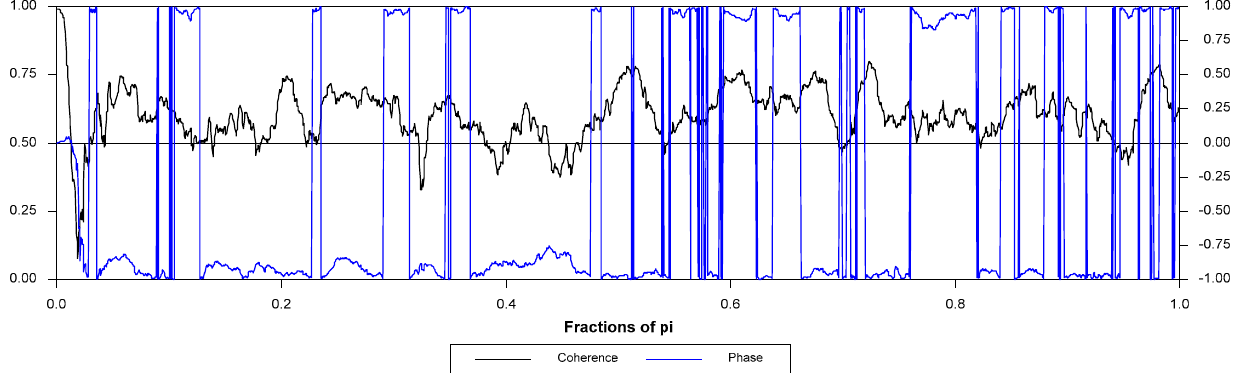
Figure 5. Coherence and phase diagrams of detrended SPRB and VIX.